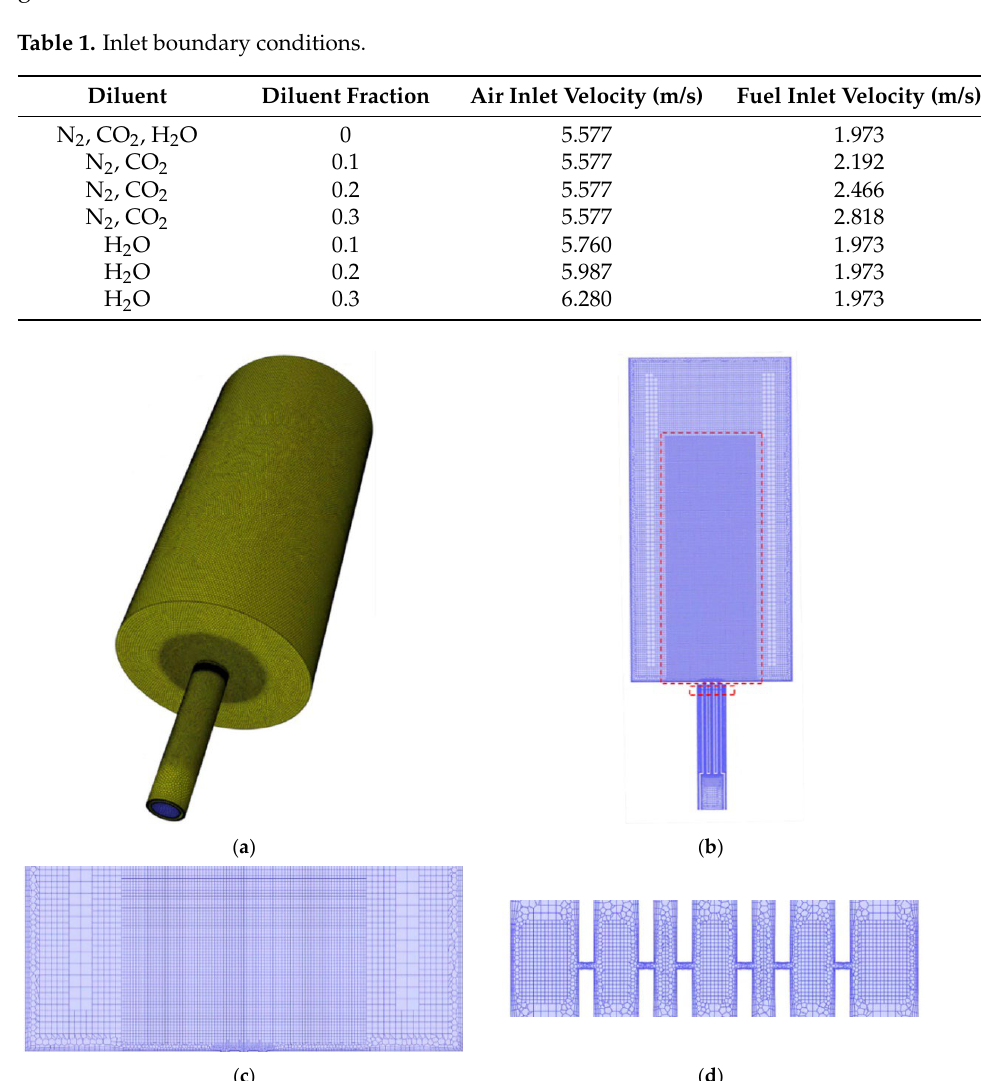
Figure 2. The fluid domain grid. (a shows the mesh contour of the fluid domain, b shows the mesh on the central section of the fluid domain, c shows a detailed view of the mesh in the dashed box of the combustion chamber region, d shows a detailed view of the mesh in the dashed box of the air–fuel mixing region.)